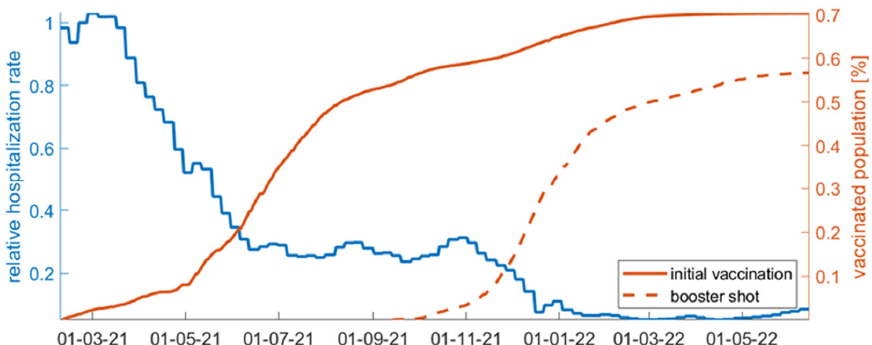
Figure 9. Relative hospitalization rate (calculated by dividing the hospitalization rate after vac- cinations by the hospitalization rate before vaccinations) depicted with the blue line against the percentage of vaccinated individuals in the population (depicted with the orange line) for the time period 1 February 2021–15 June 2022. The percentage of individuals who have received a booster shot is also shown (dashed orange line).